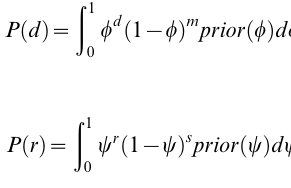
Figure 1. It rewards alignment of identical or similar residues in the same key position, and penalizes deletions and insertions.